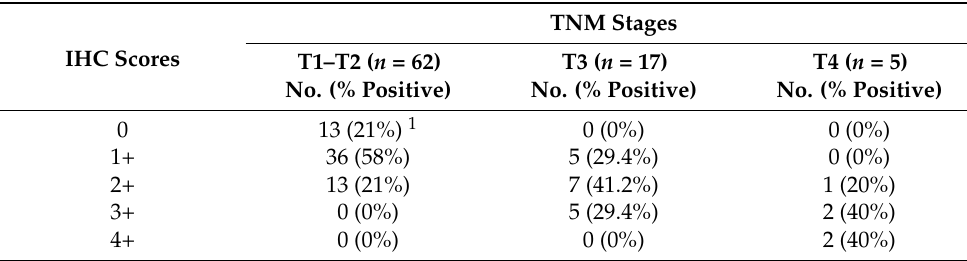
Table 1. FGFR3 positivity rates in renal pelvis tissues from Caucasian patients with upper tract urothelial carcinoma (UTUC).